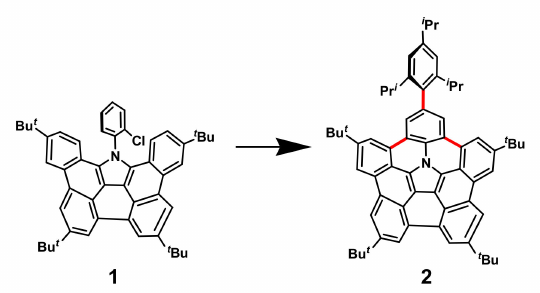
Figure 1. Examples of fluxional molecular systems: ( i ) bowl-to-bowl inversion, ( ii ) shuttling, ( iii ) pirouetting, and ( iv ) rotating.